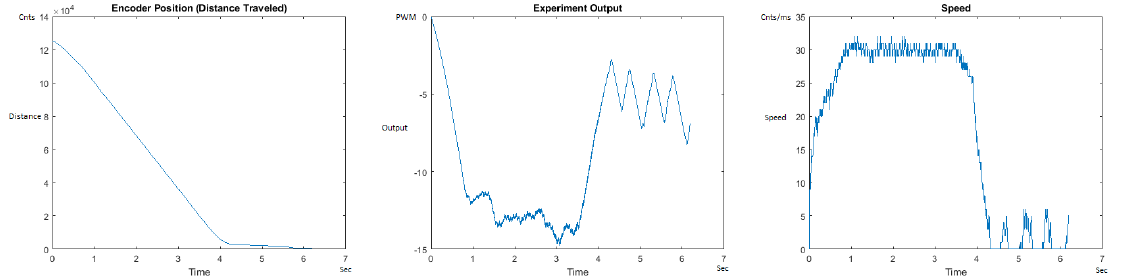
Figure 27. Encoder position, output and speed plots for PID++ DOWN operation— Vmax 30 cnts/ms, Adesired 0.055 cnts/ms 2 —10 g.